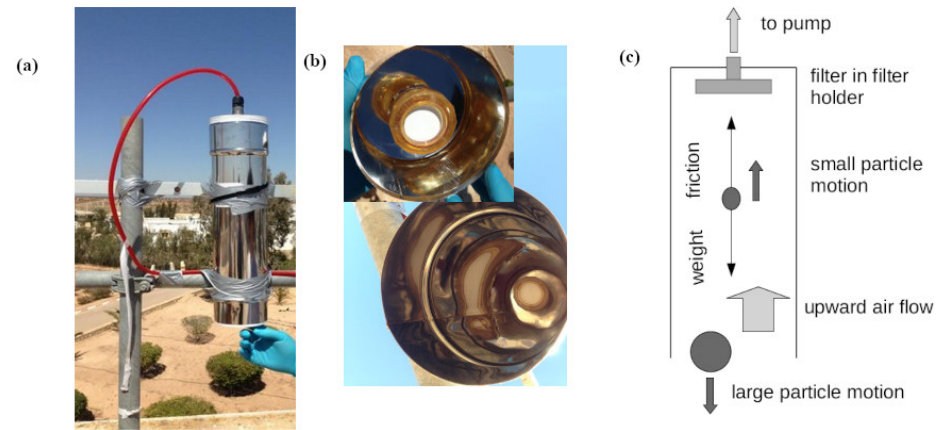
Figure 3. The VTD system. (a) VTD installation on the roof of the building. (b) Two bottom-up views of filter on filter holder inside the decanter tube. (c) Diagram of decantation system.